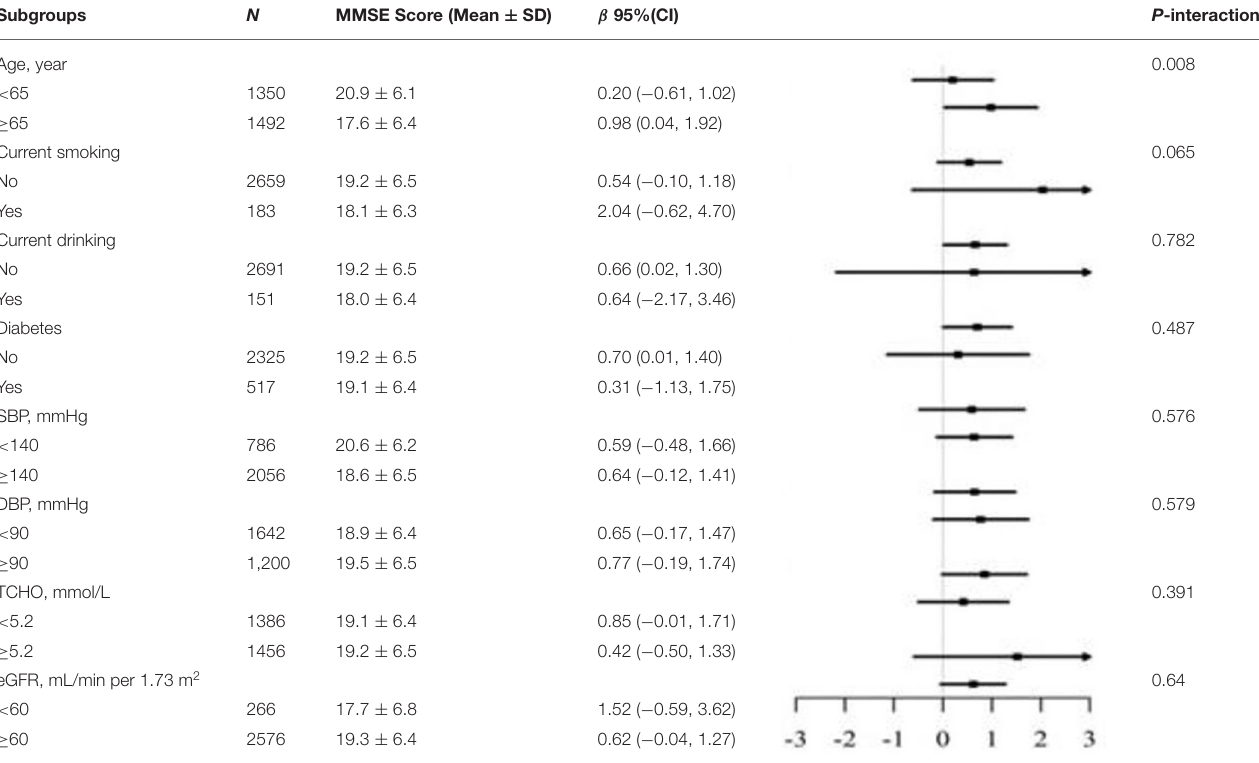
TABLE 4 | Stratified analyses of association between LAP as a common logarithm-transformed continuous variable and cognitive function represented by MMSE scores in female.